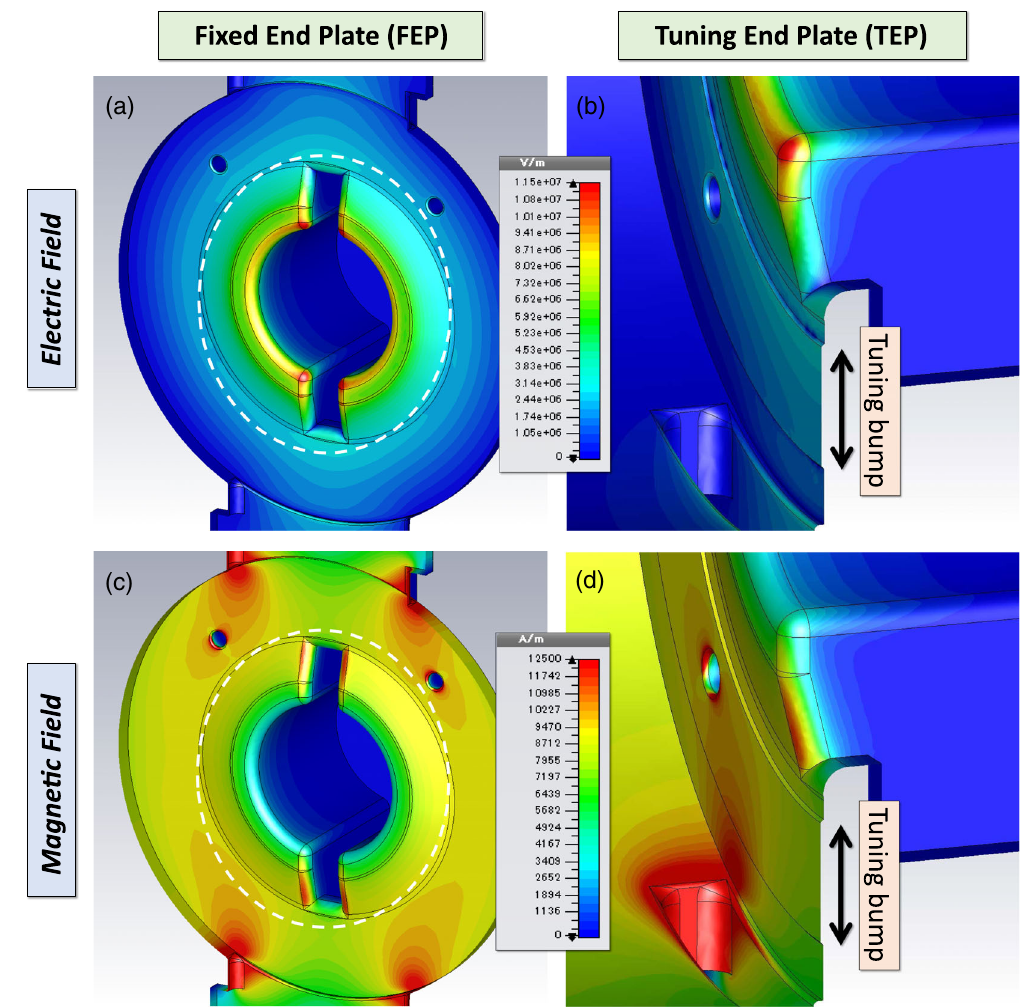
¼ 3 . 5 MV = m). The region inside the white dashed ellipse on FIG. 8. Surface field of the accelerating mode at V c ¼ 0 . 90 MV ( E acc the FEP was observable with TV camera 3, and the observable region on the TEP was almost the same. The maximum strengths of the electric and magnetic fields are 13 MV = m on the nose cone and 34 kA = m at the aperture for the HOM waveguide, respectively. (a) Electric field on the FEP. (b) Electric field on the TEP with a vertical cut plane. (c) Magnetic field on the FEP. (d) Magnetic field on the TEP with a vertical cut plane.